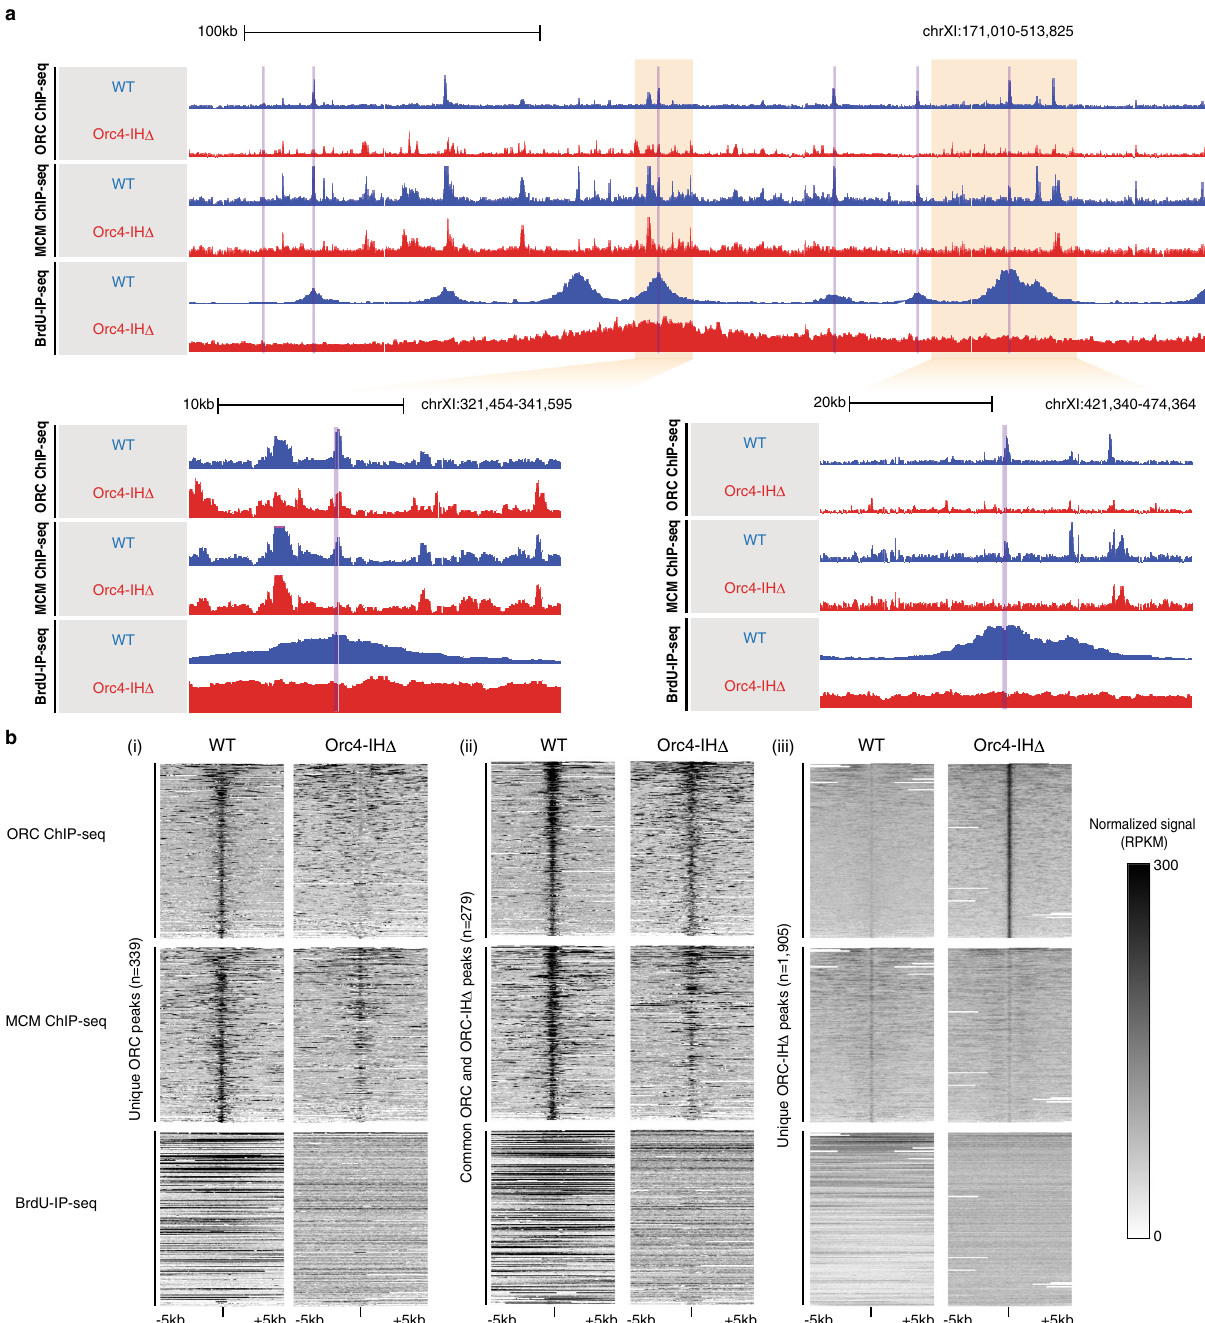
Fig. 5 Genome-wide analysis of the function of ORC-IH Δ in MCM loading and replication initiation. a Genome browser screenshots illustrate the changes in the ORC and MCM ChIP-seq, as well as BrdU-IP-seq normalized signals in WT and Orc4-IH Δ cells. For instance, examining a large region on chromosome XI (top), ORC, and MCM ChIP-seq enrichments show both consistency and differences between WT and ORC-IH Δ . However, BrdU incorporation appears dramatically altered. Zooming into speci fi c loci, while some ARSs show similar binding of ORC and MCM (bottom left), others show a loss of ORC and MCM binding in Orc4-IH Δ (bottom right). This reduction is also associated with lower BrdU incorporation. Veri fi ed ARS regions (OriDB) are highlighted in purple. Y -axis for all ChIP-seq and BrdU-IP-seq tracks within each screenshot was adjusted to the same scale for each assay. b Heatmaps demonstrate the global changes of ORC and MCM ChIP-seq and BrdU-IP-seq signals. Focusing on ±5 kb surrounding ORC ChIP-seq peaks unique to